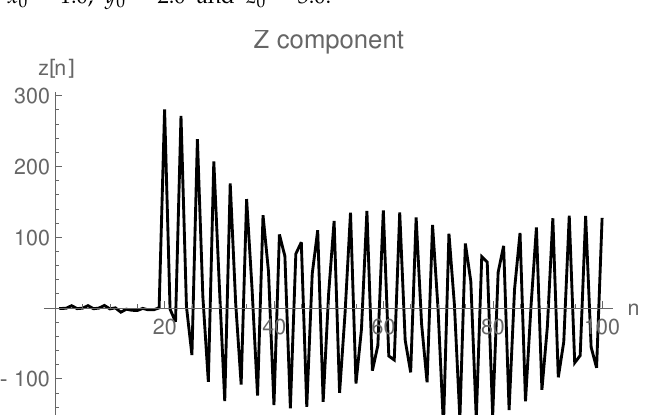
Figure 23. Graph of y n for α = 0.00001, β = 2.0, γ = 3.0, δ = 4.0, ζ = 0.00005, η = 6.0, µ = 7.0, ε = 0.00009, υ = 8.0, ρ = 10.0, σ = 11.0, ω = 12.0. with initial conditions x 0 = 1.0, y 0 = 2.0 and z 0 = 3.0.